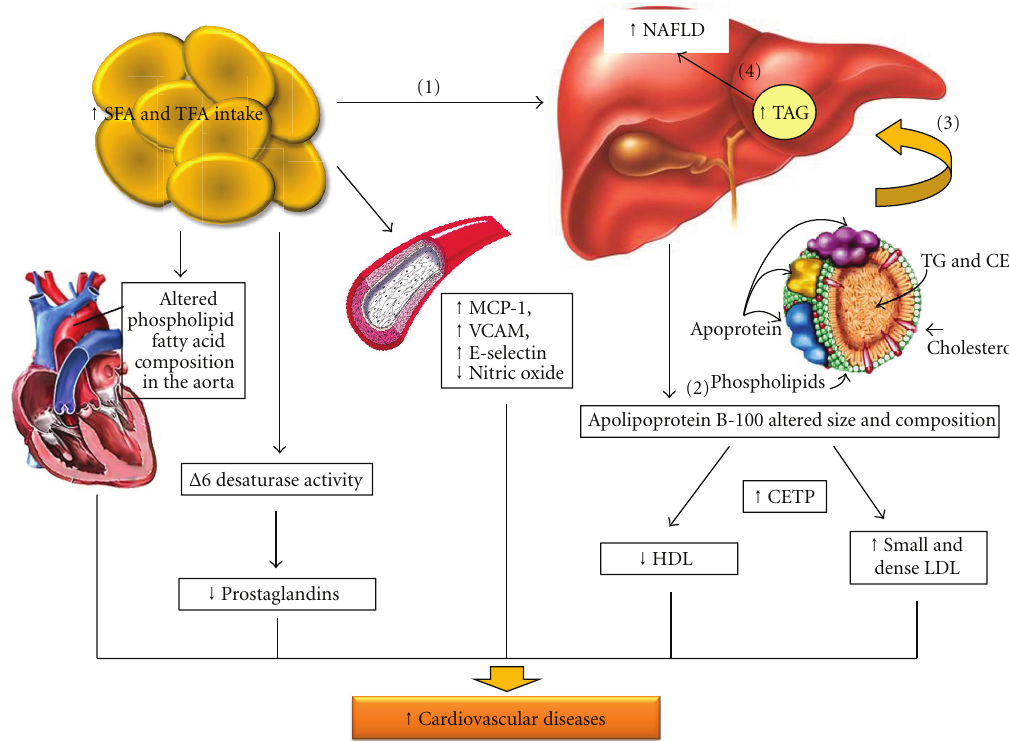
F 2: Schematic representation of SFA and TFA excess intake effects in hepatic injury, lipid metabolism, and cardiovascular risk. CE: cholesterol esteri�ed, CETP: cholesteryl ester transfer protein, HDL: high density cholesterol, LDL: low density cholesterol, MCP-1: monocyte chemotactic protein-1, NAFLD: nonalcoholic fatty liver disease, SFA: saturated fatty acids, TFA: trans fatty acids, TG: triacylglycerol, and VCAM: vascular cell adhesion